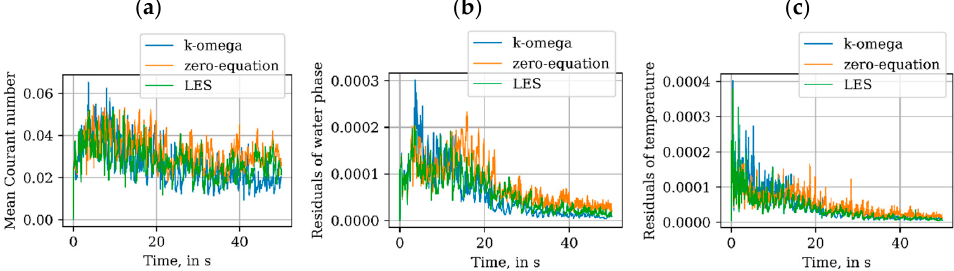
Figure 4. Time series of the ( a ) mean Courant number, ( b ) water phase, and ( c ) temperature